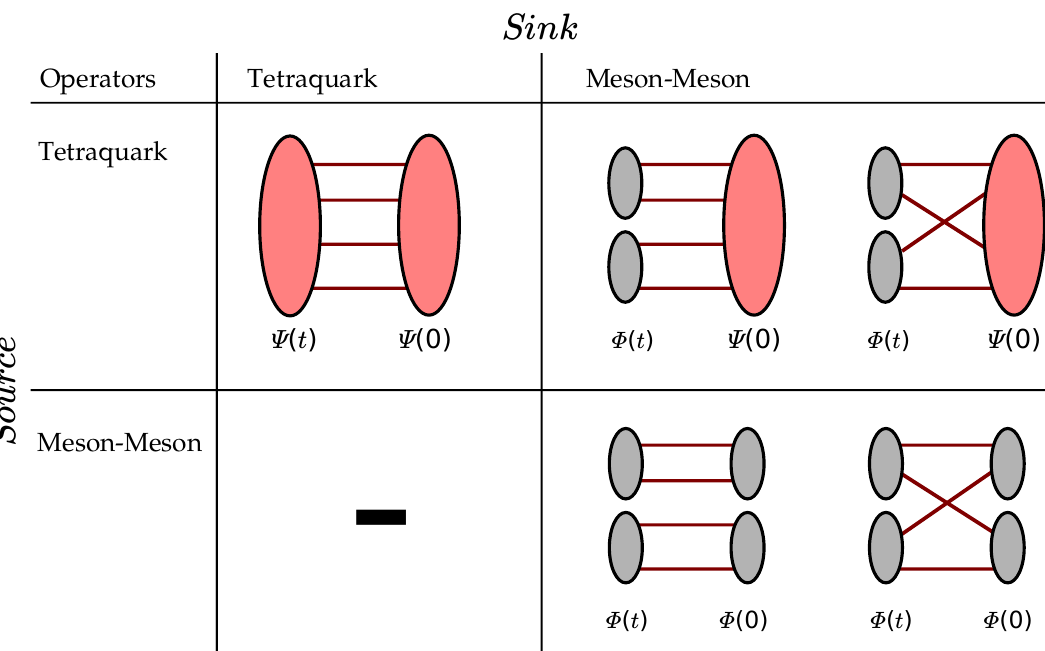
Figure 1 . A schematic representation of the types of Wick contractions required to compute the two-point correlation function matrices in this study. We use (cid:8) (grey) to depict the single- meson elementals, (cid:9) (red) to depict the tetraquark elementals and the lines joining them to depict